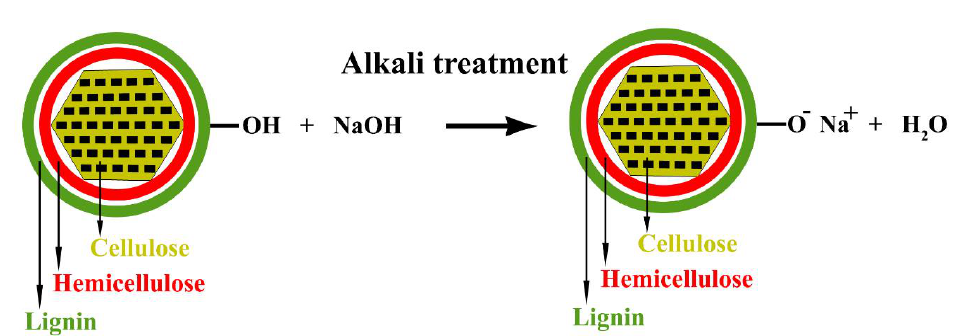
Figure 2. Schematic showing the alkaline treatment of raw natural fibers (redrawn from Ref.